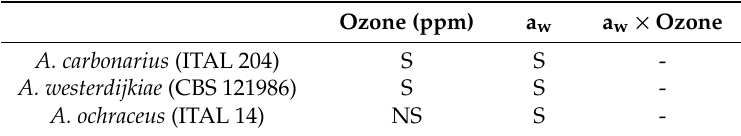
Table 2. Statistical comparison of ochratoxin A production by the species in relation to O 3 and a w × O 3 using ANOVA